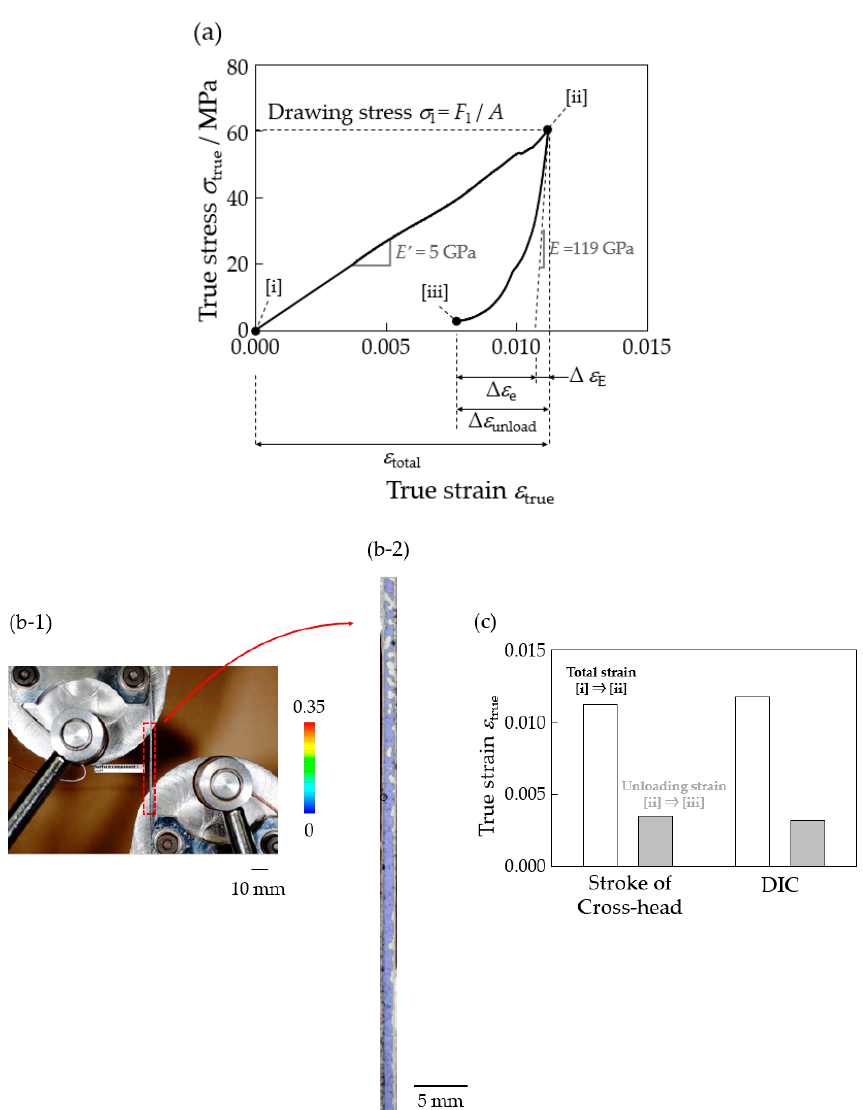
Figure 16. Results of the loading-unloading tensile test of the drawn copper tube at the die reduction R e of 0.17 and the drawing speed ratio β of 1.10. ( a ) Loading-unloading curve. The parameters Δ ε E and Δ ε total are the elastic strain and the total strain, respectively. The parameter E ’ is the apparent elastic modulus during loading. The symbols [i], [ii], and [iii] indicate the origin, the end point of loading, and the end point of unloading, respectively, ( b-1 ) distribution of the equivalent strain, ( b-2 ) magnified view of ( b-1 ), and ( c ) comparison of the true strain obtained by the universal testing machine and the DIC. The symbols [i]–[iii] coresspond to Figure 16 a .